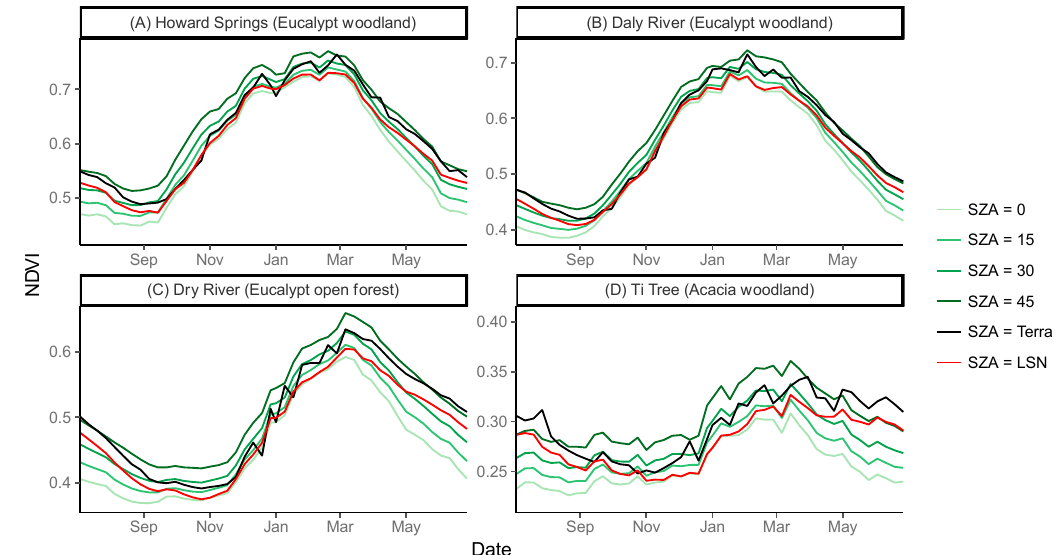
Figure 4. Mean seasonal profile of Bidirectional Reflectance Distribution Function (BRDF)-corrected normalised di ff erence vegetation index (NDVI) from 2010 to 2018, including NDVI SZA-Terra , NDVI SZA-LSN, NDVI SZA-0 , NDVI SZA-15 , NDVI SZA-30 and NDVI SZA-45 at 4 NATT flux tower sites. All NDVIs have been adjusted to the nadir view. The shaded area indicates the 95% confidence interval of the mean.